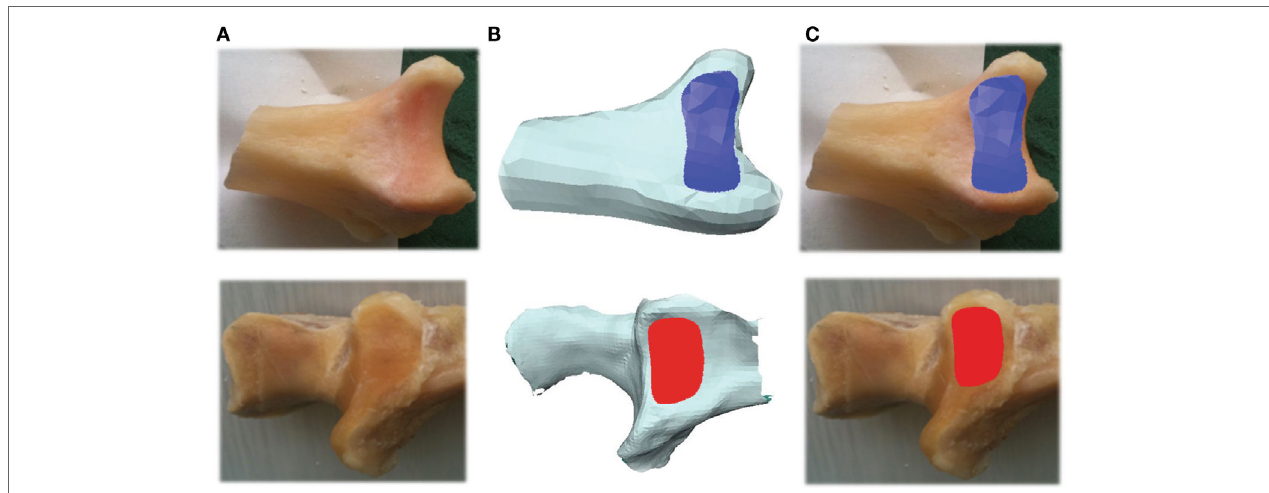
FigUre 1 | Photograph of PrUJ and DrUJ being analyzed (a) . 3D image of radioulnar joint as seen within Avizo ® program (B) . Articulating surface area of radioulnar joint superimposed onto photograph (c) . DRUJ (blue), distal radioulnar joint; PRUJ (red), proximal radioulnar